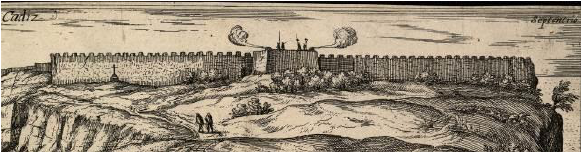
Figure 3. Detail of the representation of Georg Hoefnagel where the earth wall is observed, 1564. Civitatis Orbis Terrarum (Cartographic and Geological Institute of Catalonia).